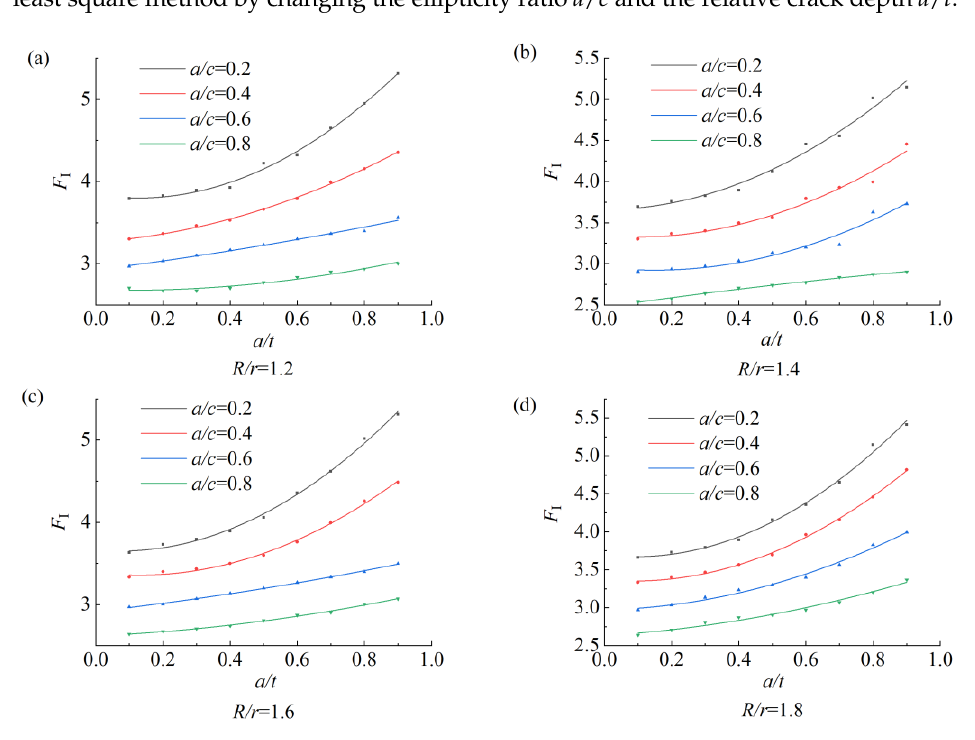
Table 3. The binomial fitting results of the corrected shape coefficient F I and the crack relative depth.